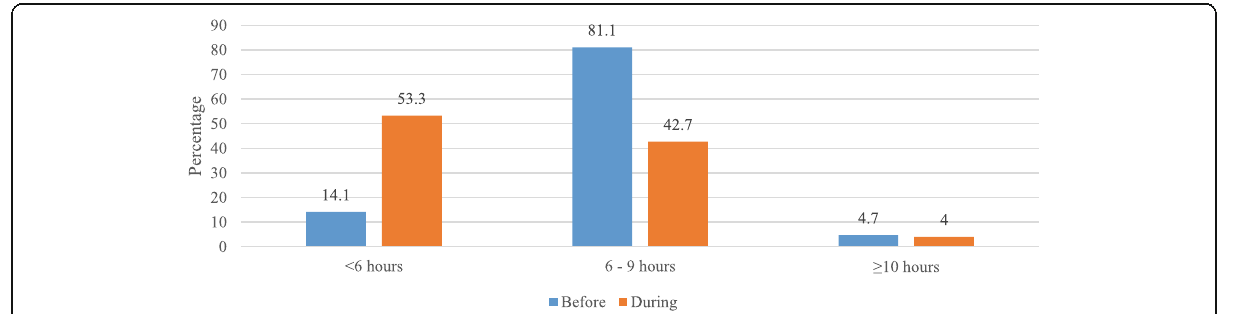
Fig. 4 Comparison of regular sleeping hours before and during the COVID-19